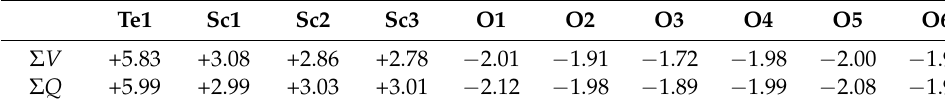
Table 4. Charge distribution calculated with BL/BS ( Σ V ) and C HARDI ( Σ Q ). Te1 Sc1 Sc2 Sc3